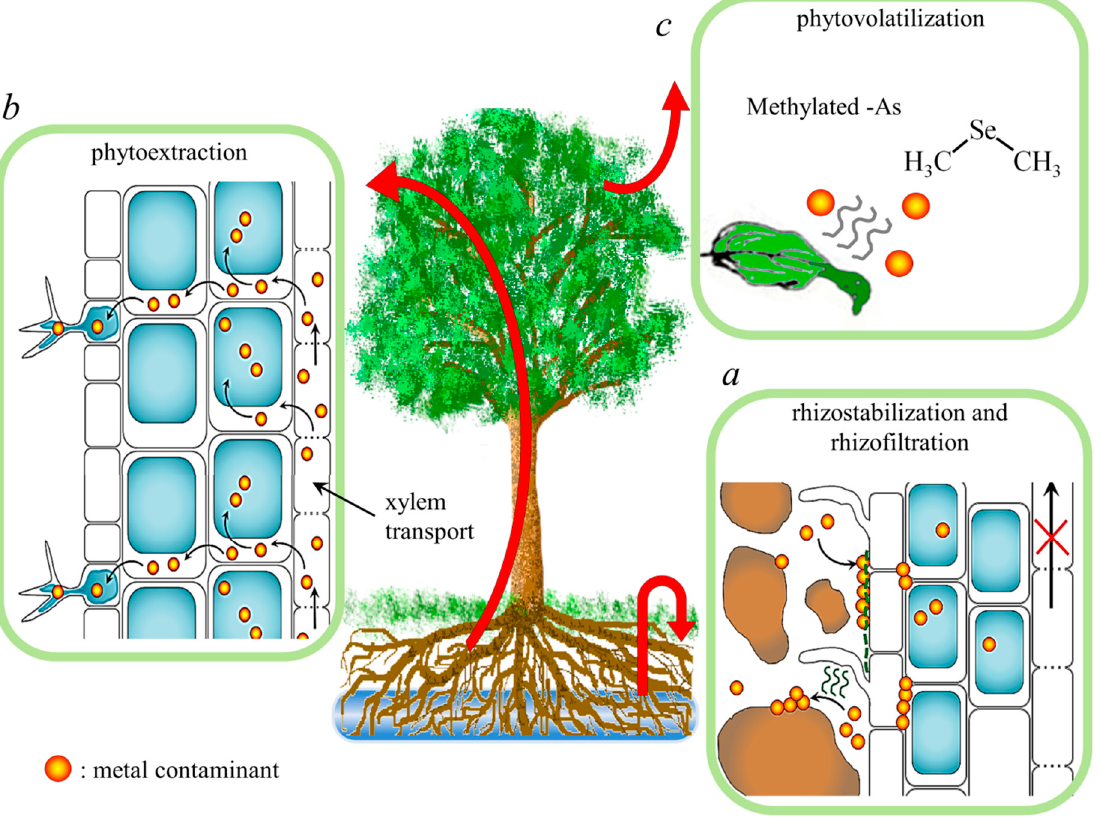
Figure 1. The main aspects of phytoremediation: the main steps involved in phytoremediation of heavy metals, which include ( a ) metal (yellow dots) adsorption on soil particles or cell walls (induced by rhizosphere metabolism) and compartmentalization of metals into root cell vacuoles (blue circles inside cells), preventing transport to the shoot; ( b ) metal accumulation in aerial organs (e.g., in vacuoles or trichomes) upon root-to-shoot xylem transport; ( c ) for particular metalloids (e.g., Se and As), leaf metabolism allows volatilization of the toxic compound.